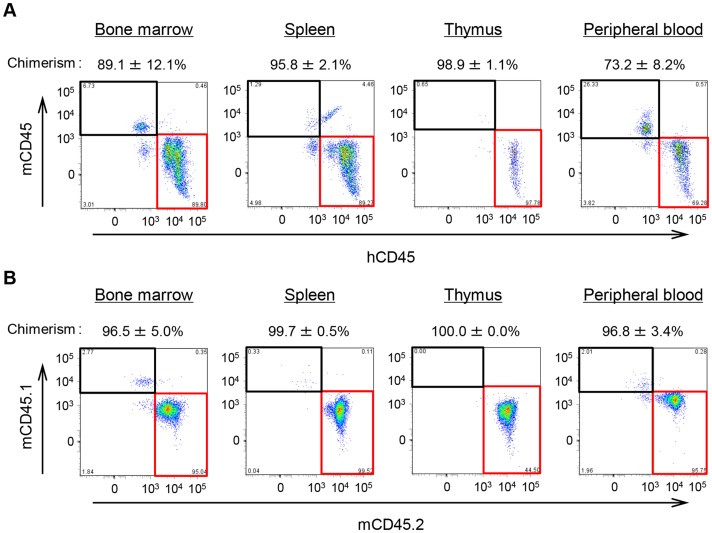
Establishment of hematopoietic cell lineages in NOG mice.Flow cytometric analysis of leukocytes in the peripheral blood and hematopoietic organs of untreated Hu-NOG (A) and Mo-NOG (B) mice. Rates of leukocyte chimerism in Hu-NOG mice were calculated as the percentage of hCD45+mCD45− cells in the total CD45+ cell population (the sum of human and mouse CD45+ cells). Data represent the mean ± standard deviation (SD; n = 7 or n = 8). Rates of leukocyte chimerism in Mo-NOG mice were calculated as the percentage of mCD45.2+mCD45.1− cells in the total CD45+ cell population (the sum of mCD45.1+ and mCD45.2+ cells). Data represent the mean ± SD (n = 6–8).